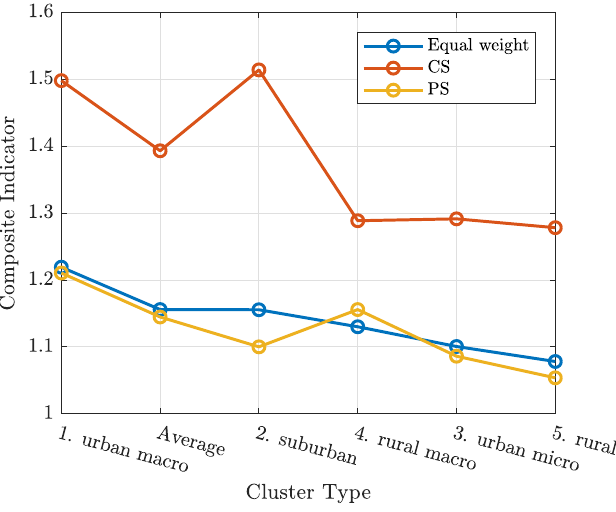
Figure 2. Composite indicators according to